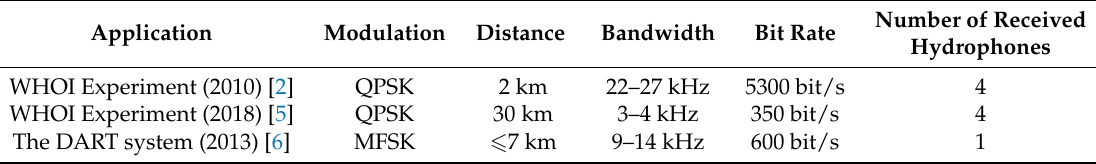
Table 1. Experiments or applications of the cableless